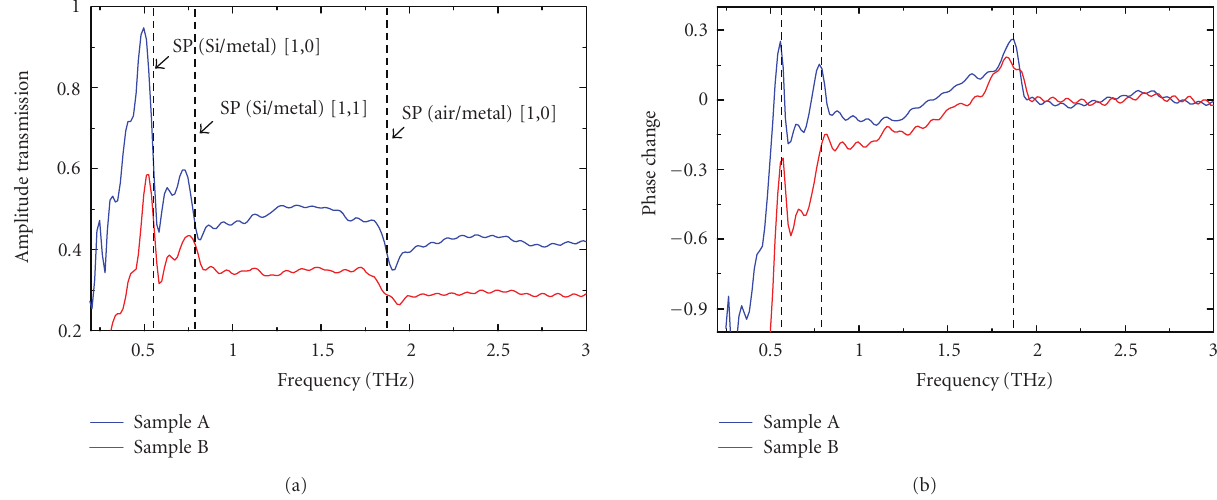
Figure 2: (a) Amplitude transmission of terahertz pulses through the array samples A and B. (b) Corresponding phase change in radians. The dashed lines indicate the SP resonant